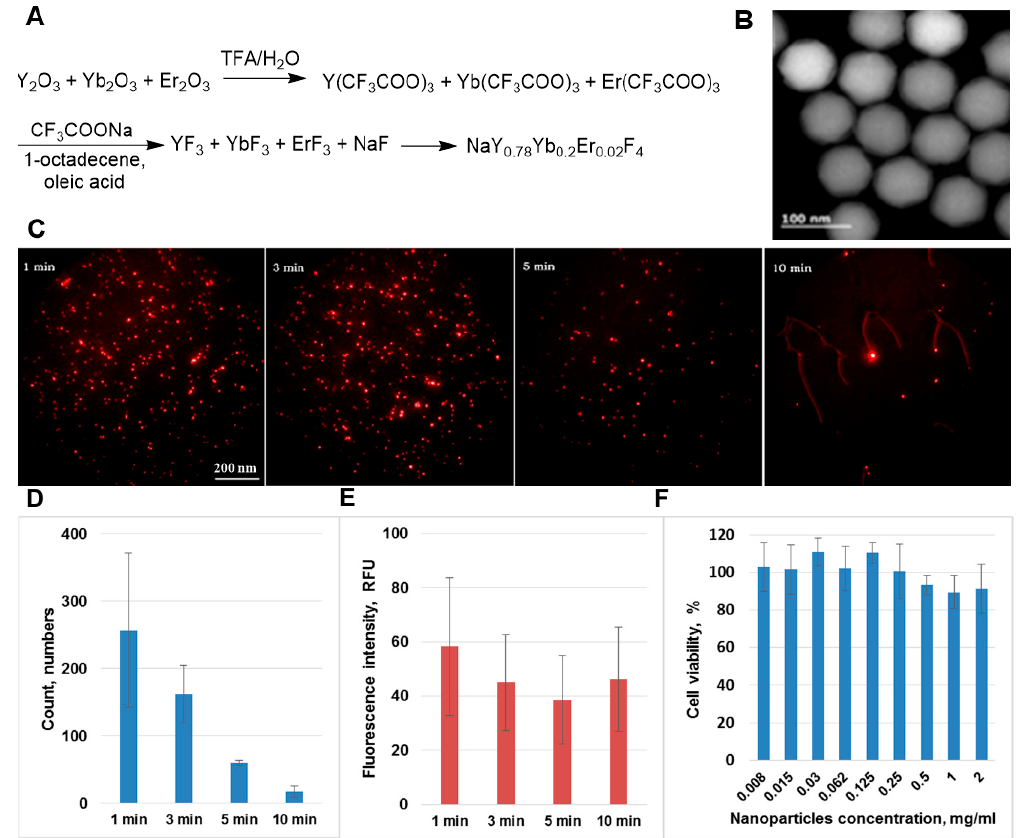
Figure 2. Synthesis of upconverting nanoparticles ( A ). Microphotographs of nanoparticles from transmission electron microscope JEM-ARM200F (Jeol, Tokyo, Japan) operated at 200 kV and equipped with large solid-angle CENTURIO EDX detector ( B ). Microphotographs of blood samples obtained using Falcon EMCCD camera (Raptor Photonics, Milbrook, UK), equipped with F = 0.95 objective 1, 3, 5, 10 min after injection of nanoparticles modified with PEG-lipid 4 ( C ). Count ( D ) and mean fluorescence intensity ( E ) of nanoparticles modified with PEG-lipid 4 in blood samples obtained from microphotographs using ImageJ (NIH, Bethesda, MD, USA) software (ver. 1.53p). Viability of Bj-5ta fibroblasts after 24 h incubation with nanoparticles, MTT assay. Data are mean ± SD; cell viability of control (intact) cells taken to be 100% ( F